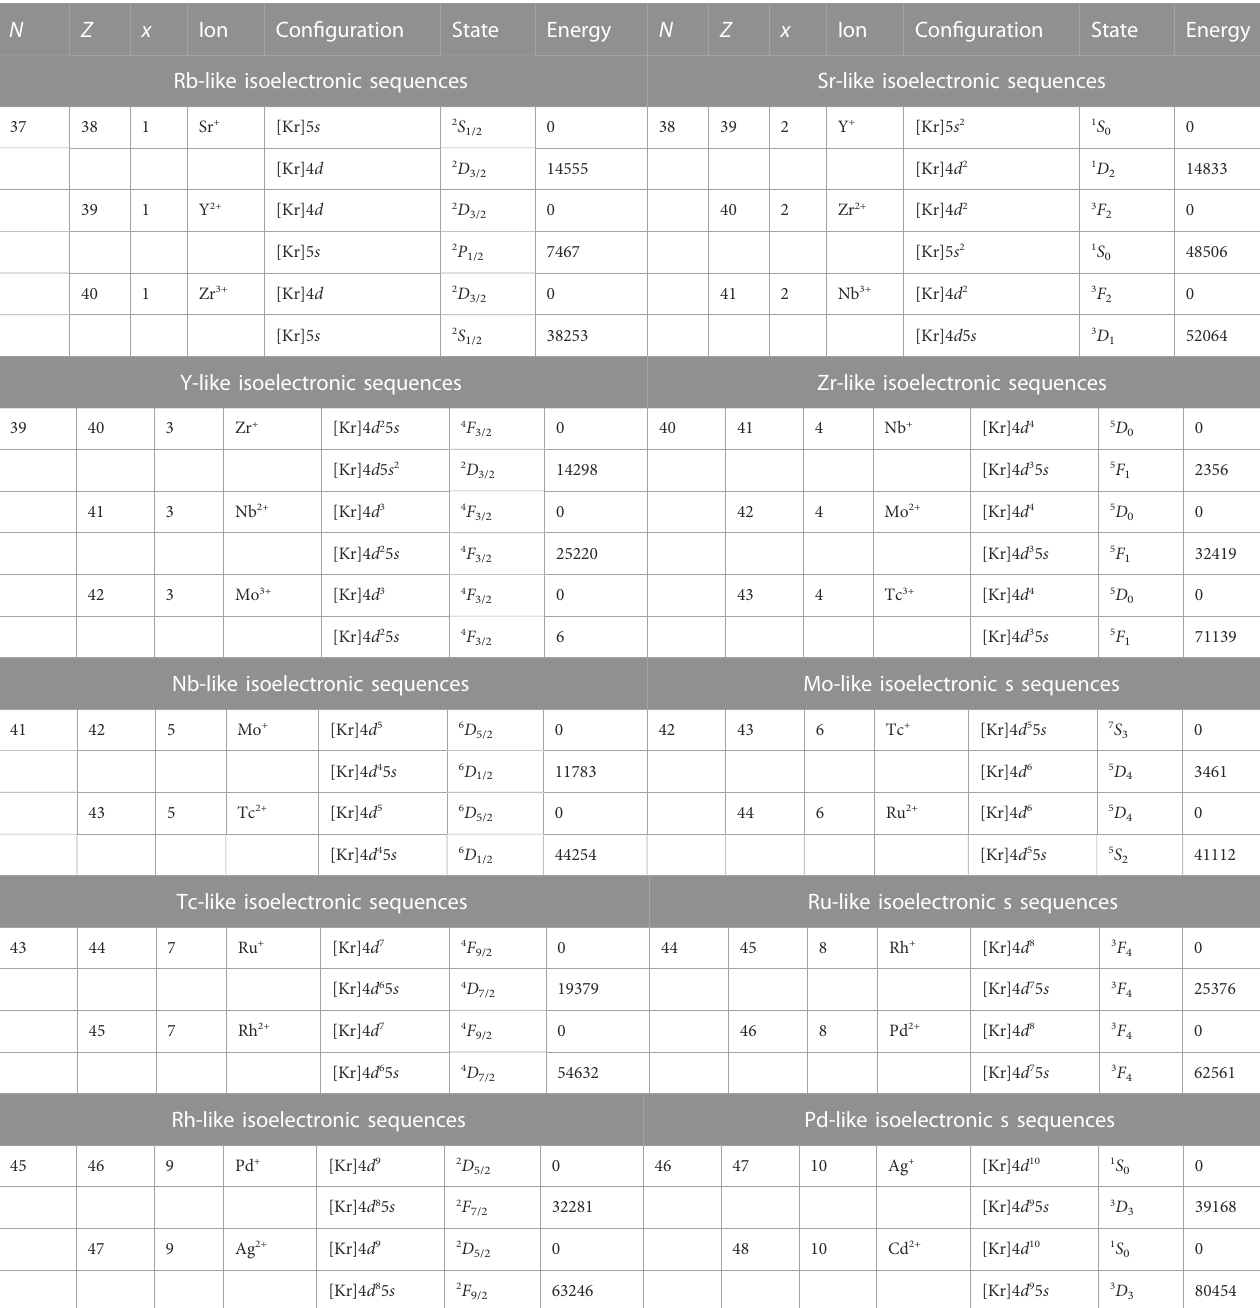
TABLE 7The energy level of some ions in the Rb-like ( N = 37), Sr-like ( N = 38), and the fi fth row transition metals from Y- to Pd-like ( N = 39 − 46) isoelectronic sequence HCIs, where N is the number of the electron, Z is the atomic number, and x is the number of valence electron. [Kr] ” 1 s 2 2 s 2 2 p 6 3 s 2 3 p 6 3 d 10 4 s 2 4 p 6 . The data are from the NIST database [120] and in cm − 1